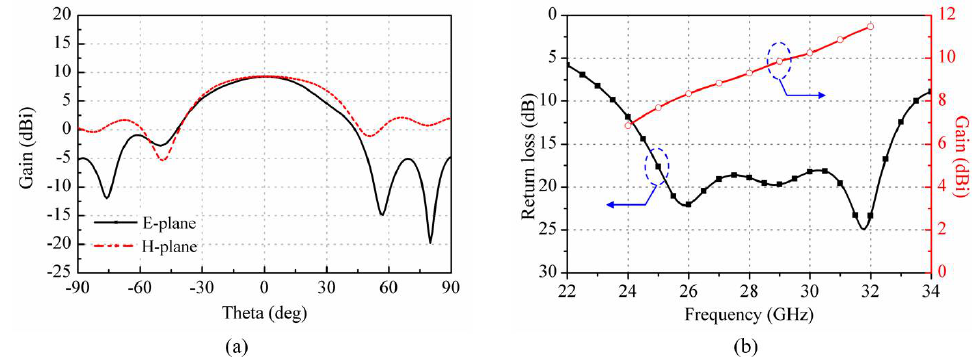
Figure 4. Simulated Yagi antenna parameters: ( a ) radiation pattern at 28 GHz, and ( b ) return loss (left axis) and gain (right axis).